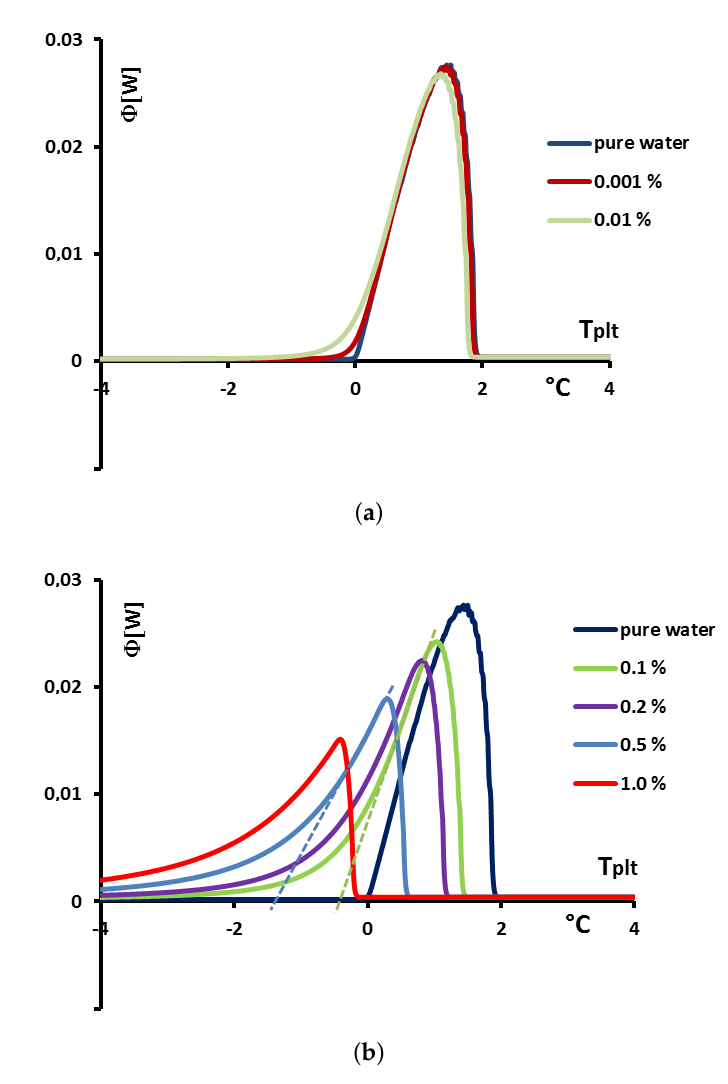
Figure 24. DSC curves at β = 0.5Kmin − 1 for solutions at various concentrations and for pure water. ( a ) Very dilute cases; ( b ) Classical dilute